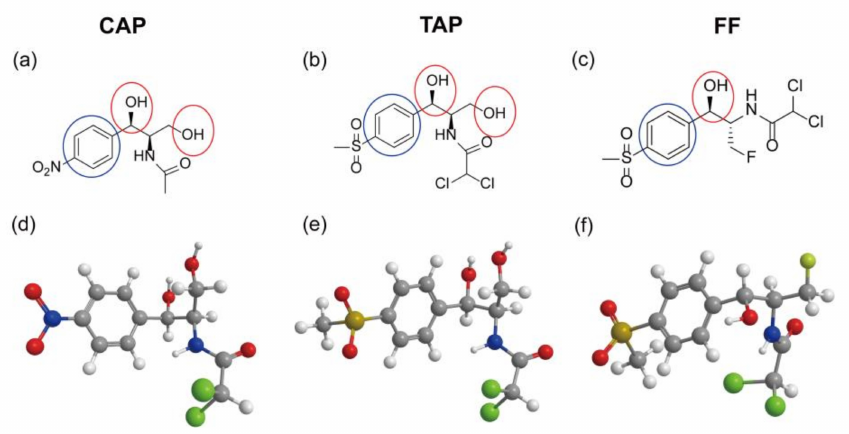
Figure 6. The chemical ( a – c ) and 3D ( d – f ) structure of the three analytes. ( a , d ) CAP, ( b , e ) TAP, and ( c , f ) FF. The red and blue circle ( a – c ) indicated the binding sites of analytes with the 3D COP by π – π interaction and H-bonding, respectively. The 3D structure was obtained by optimizing the minimized energy using ChemDraw